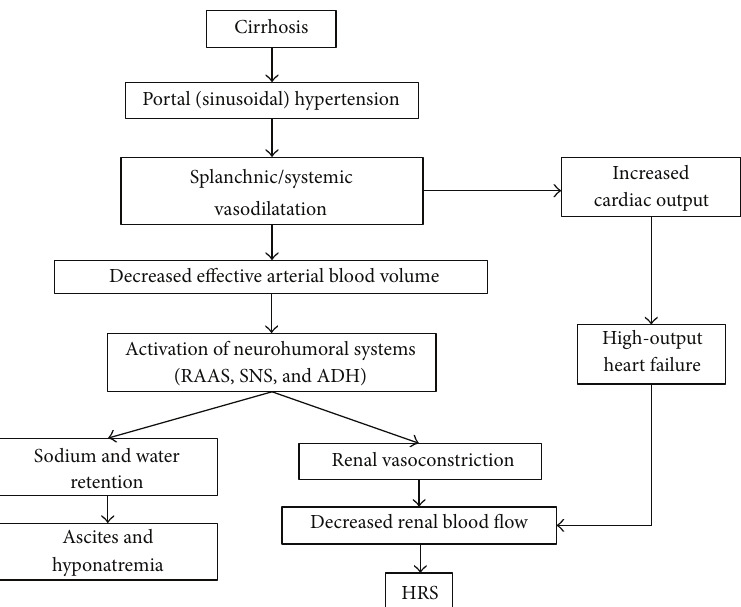
Figure 1: A flow diagram outlines the main pathophysiologic mechanisms involved in the development of HRS (reproduced with permission from“JohnWileyandSons,”Garcia-Tsaoetal.[1]).RAAS—reninangiotensinaldosteronesystem;SNS—sympatheticnervoussystem;ADH— antidiuretic hormone; HRS—hepatorenal